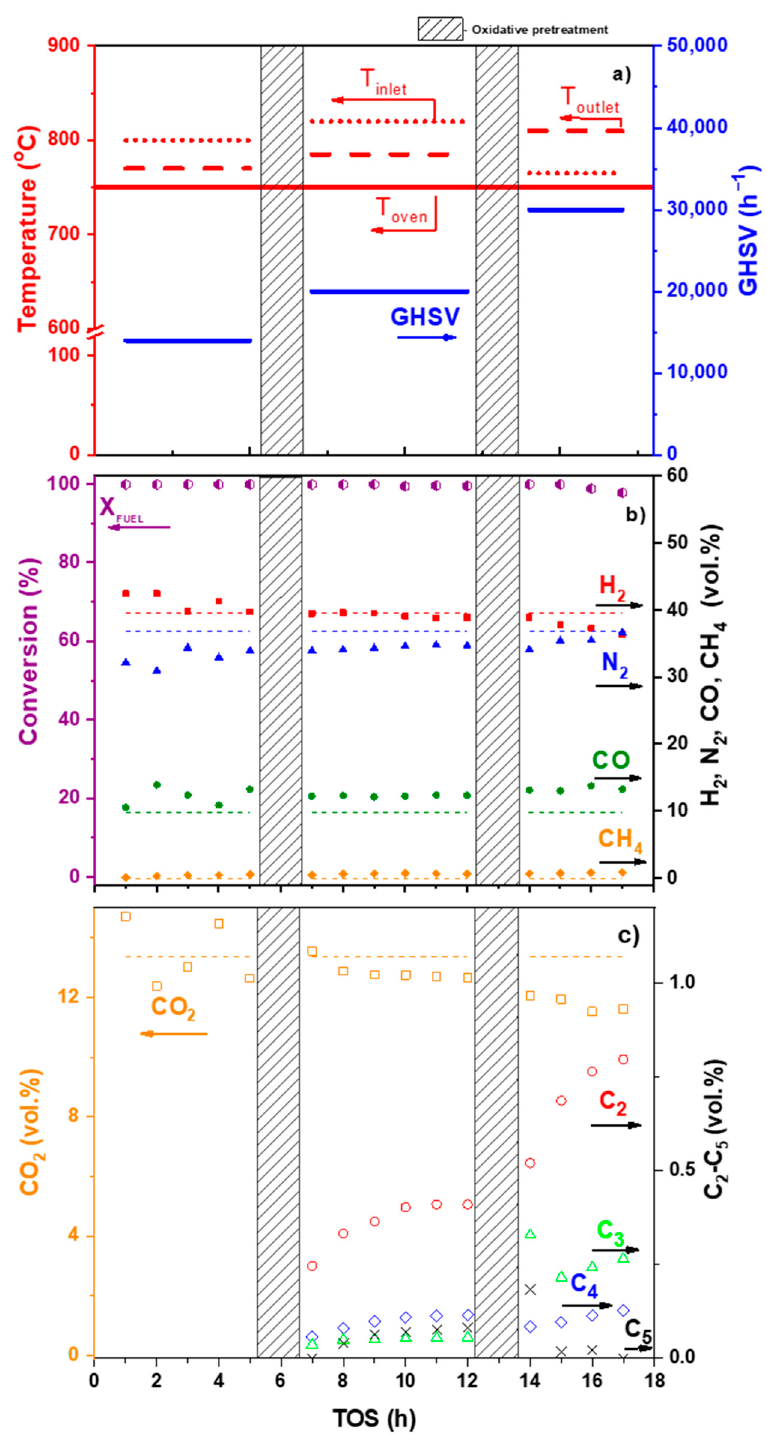
Figure 11. DF ATR over Rh/CZB/FCA under the following conditions: GHSV 14,000–30,000 h − 1 , T oven = 750 ◦ C, H 2 O/C = 2.5, O 2 /C = 0.4. Experimental conditions ( a ); diesel fuel conversion (%) and H 2 , N 2 , CO, CH 4 concentrations (vol. %) (dry basis) ( b ); CO 2 and by-products concentrations (vol. %) (dry basis) ( c ). Points—experiment; dashed lines—equilibrium concentrations. Adapted from [91].